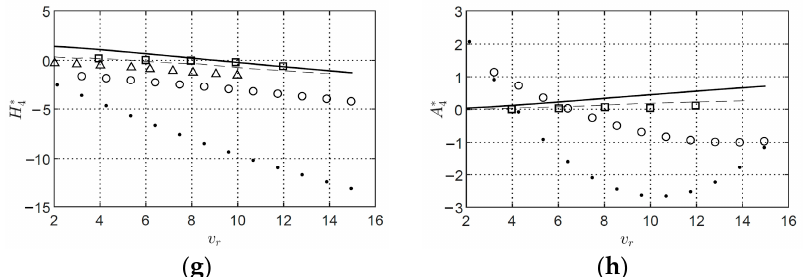
Figure 27. Comparison of aerodynamics derivatives from 2DOF for Setup 2. (o) Polynomial fit from pitch using MITD method, (…) polynomial fit from heave using MITD method, ( □ ) wind tunnel test [42], ( ∆ ) wind tunnel test [2], ( ‒ ‒ ) water channel tests, ( ― ) fl at plate by Theodorsen. ( a ) 𝐻 (cid:2869)∗ ; ( b ) 𝐴 (cid:2869)∗ ; ( c ) 𝐻 (cid:2870)∗ ; ( d ) 𝐴 (cid:2870)∗ ; ( e ) 𝐻 (cid:2871)∗ ; ( f ) 𝐴 (cid:2871)∗ ; ( g ) 𝐻 (cid:2872)∗ ; ( h ) 𝐴 (cid:2872)∗ .